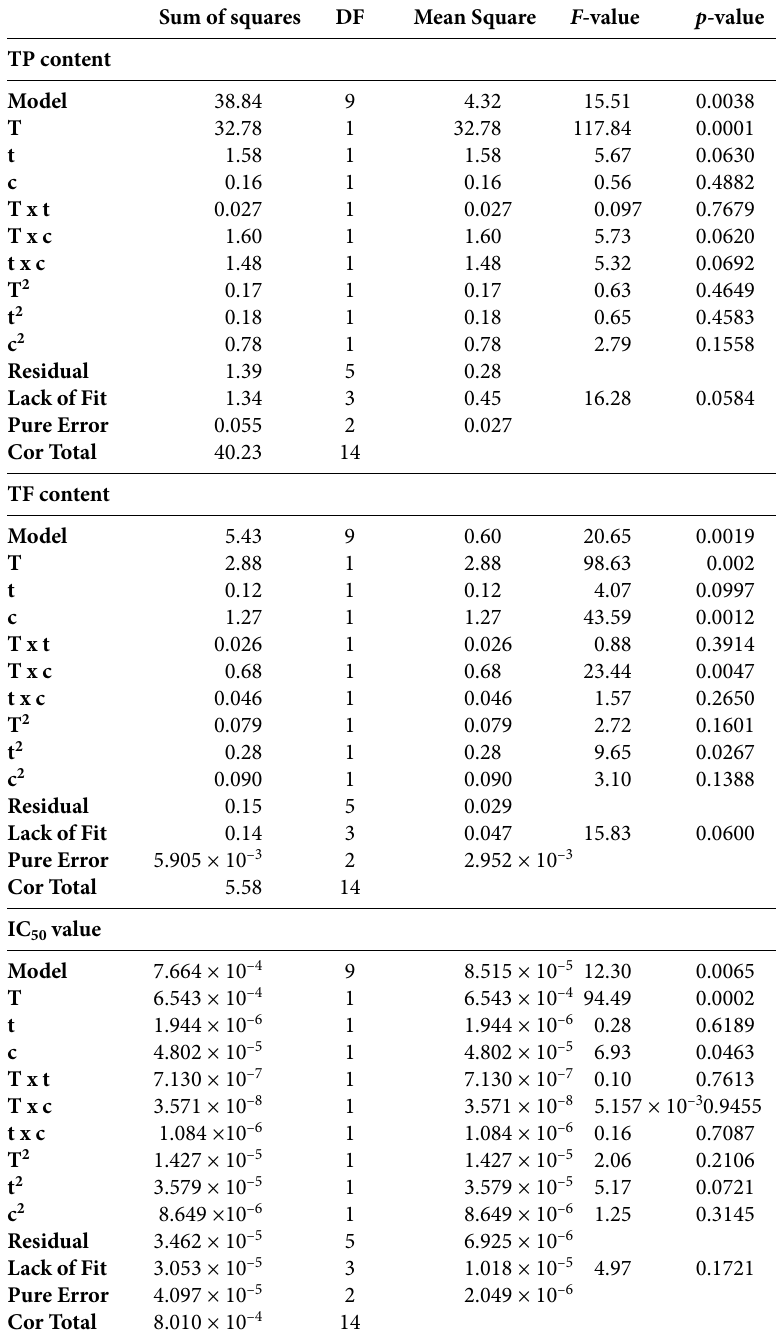
Table 4. Analysis of variance (ANOVA) of the fitted second-order polynomial model for TP content, TF content and IC 50 value Sum of squares DF Mean Square F -value p